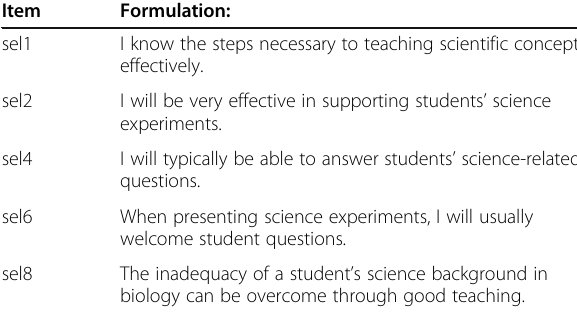
Table 5 Scale ʻ Self-efficacy in teaching biology ’ (adapted from Bleicher,